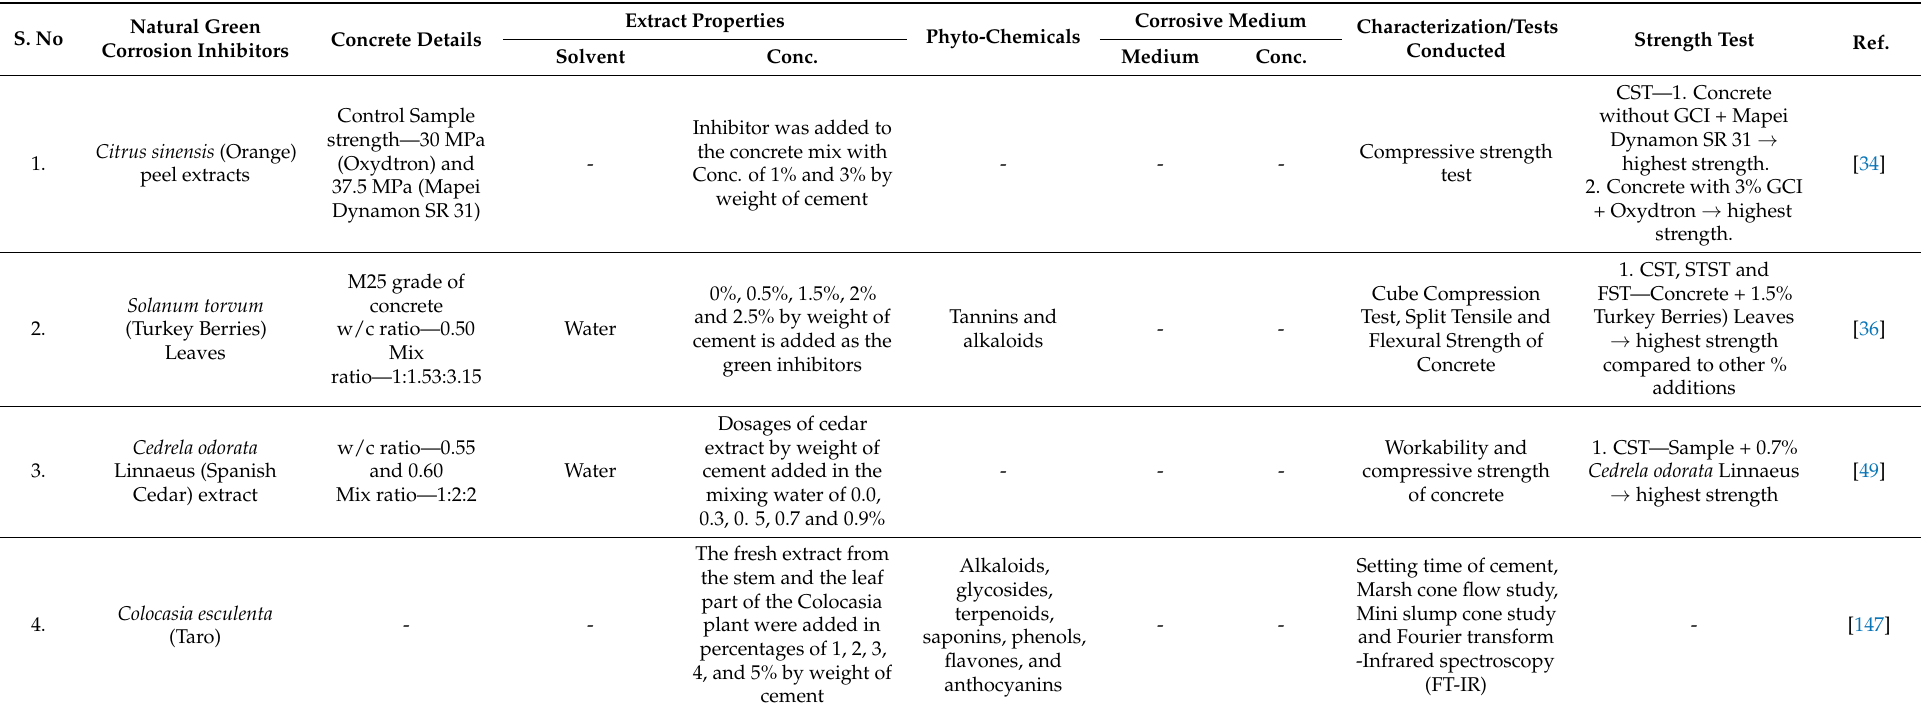
Table 5. No usage of